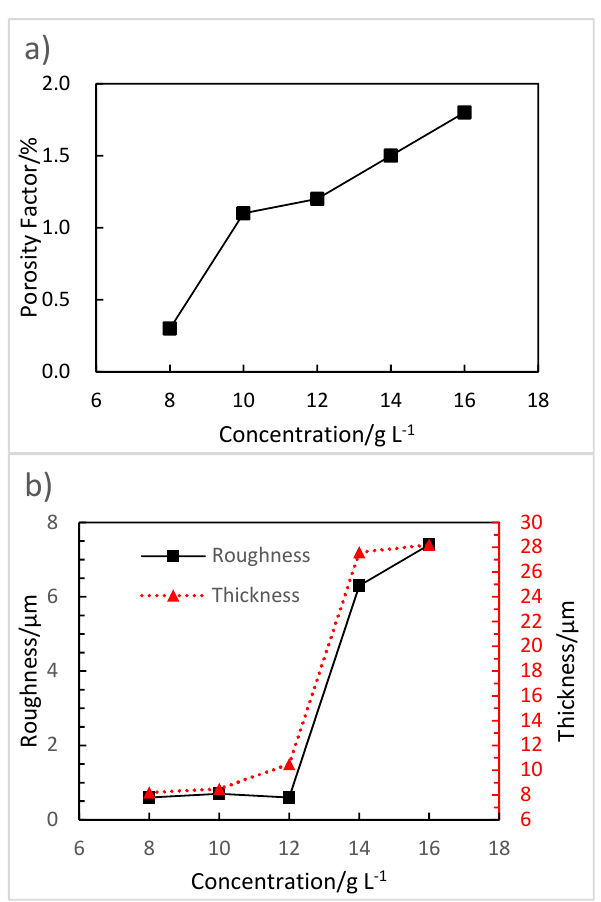
Figure 3. Influence of sodium silicate concentration (8–16 g L − 1 ) on porosity, thickness, and roughness of the MAO film: ( a ) porosity factor and ( b ) roughness and thickness.